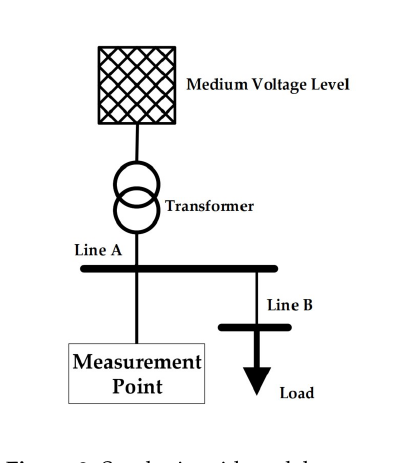
Figure 9. Synthetic grid